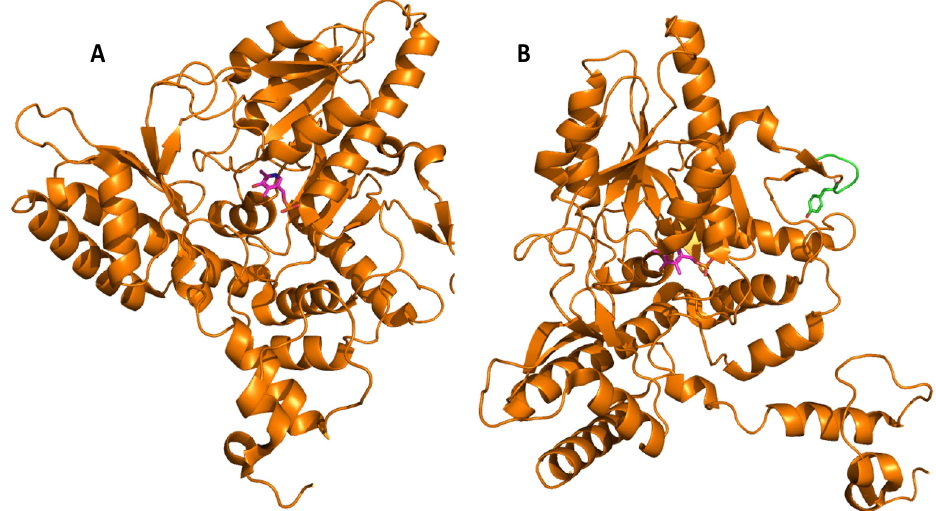
Figure 4. Overall secondary structure of the glutamate decarboxylase monomer from L. brevis (PDB code 5GP4). ( A ) Chain A is represented as an orange cartoon, and its prosthetic group PLP is represented as sticks colored by atom type, with carbons shown in magenta. ( B ) Position of the Y308-E312 flexible loop shown in green. The conserved Y308 is represented as sticks, colored by atom types, with carbons being green. All images were made using the PyMOL Molecular Graphics System, v. 2.3.0. for Linux. Molecular docking of the substrate glutamate into the active-site of the holo-form of L. brevis